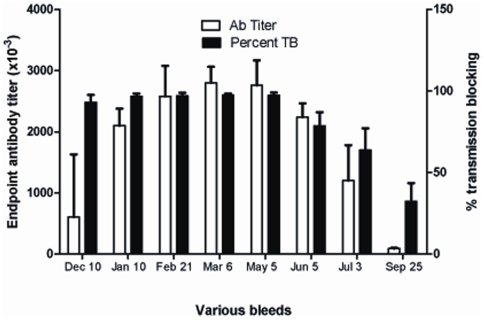
Follow up of immune responses elicited by CH-rPfs48/45 in baboons.Analysis of anti-CH-rPfs48/45 IgG titers (open bars) and percent transmission blocking activity (closed bars) upto 7 months post second boost in baboons. Results show mean antibody titer and mean transmission blocking activity of 5 baboons +95% CI.